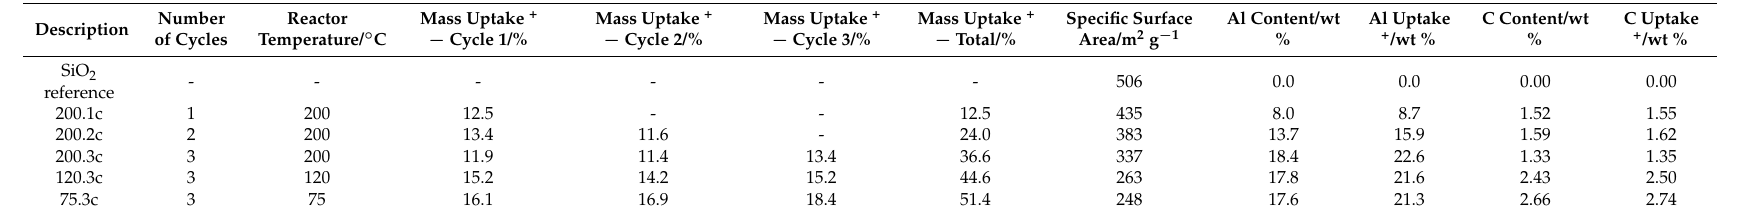
Table 1. Sample family of SiO 2 powder coated samples with AlO x using TMA and H 2 O.